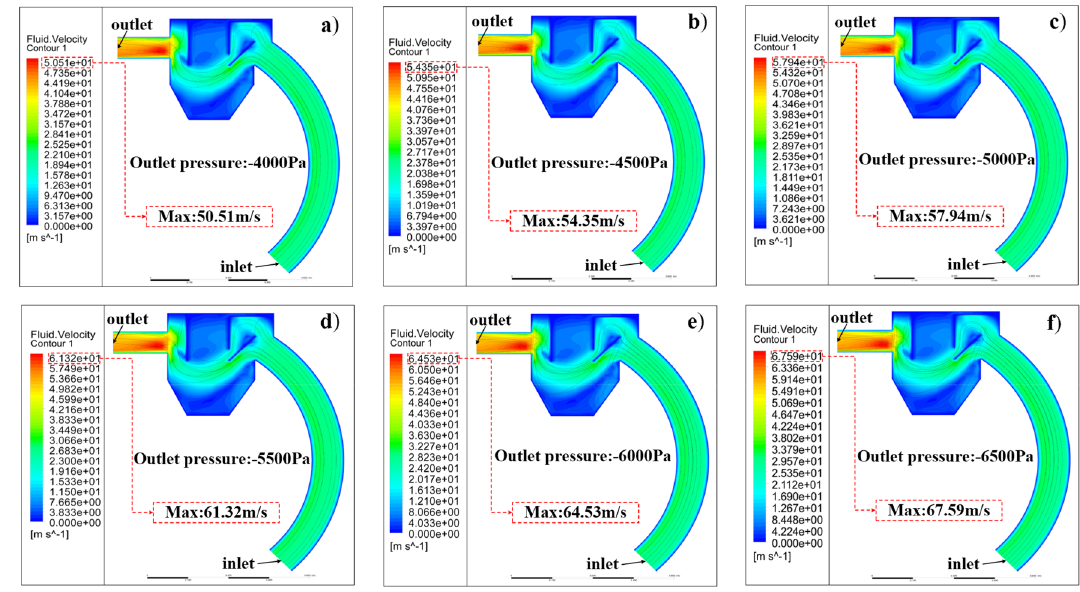
Figure 7. Airflow distribution and flow lines in the shot blasting machine recovery